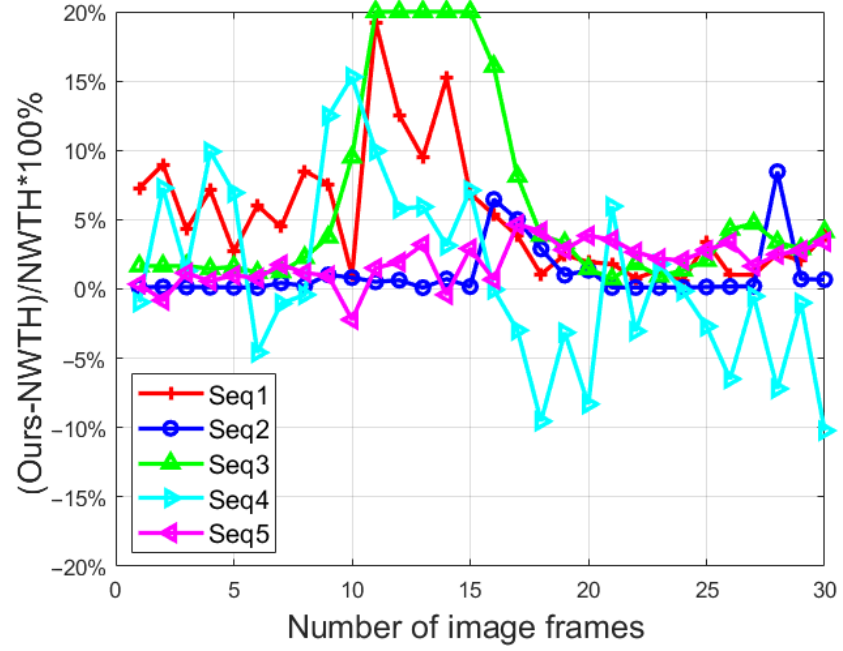
Figure 13. The ratio of BSF difference to NWTH. Capped at 20% for better presentation.